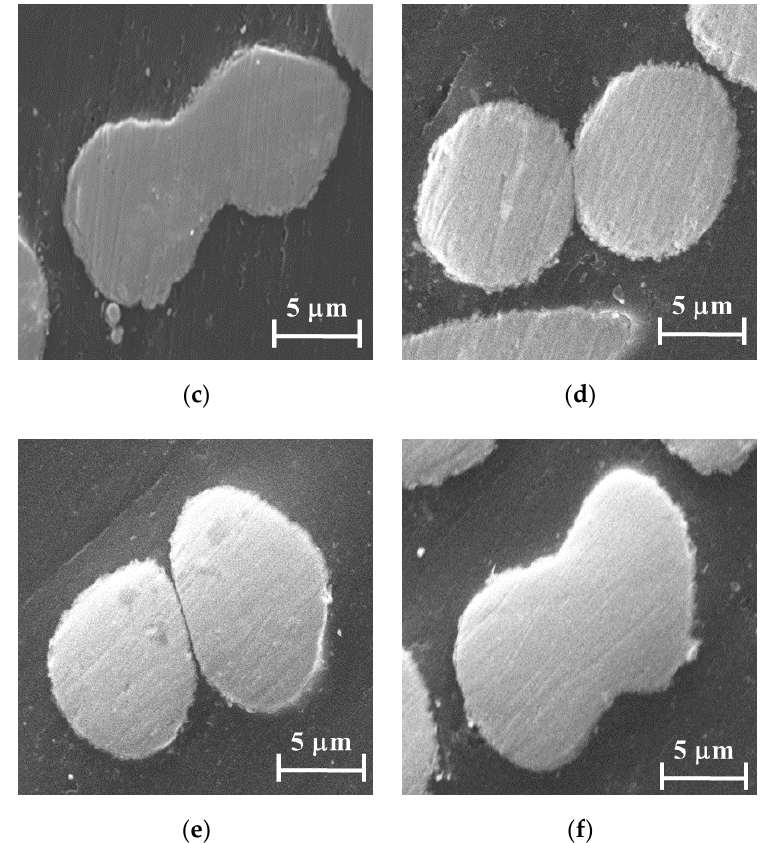
Figure 6. Experimental results of two 8 µ m 316L stainless steel fibers with angles of 0~ π / 2 sintered at 1200 °C for 2 h: ( a ) section morphology of sintering metal fibers; ( b – f ) high magnification morphologies.